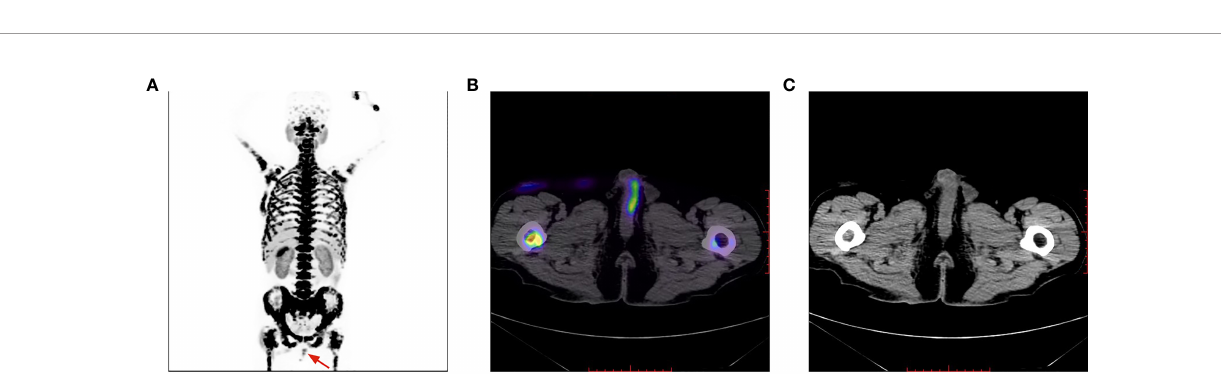
FIGURE 6 | Penile lesion was enlarged with a higher SUV max of 7.4 (B) ; meanwhile, systemic bone metastasis was certi fifi ed (A) . No morphological abnormalities of the penis detected on CT imaging (C)